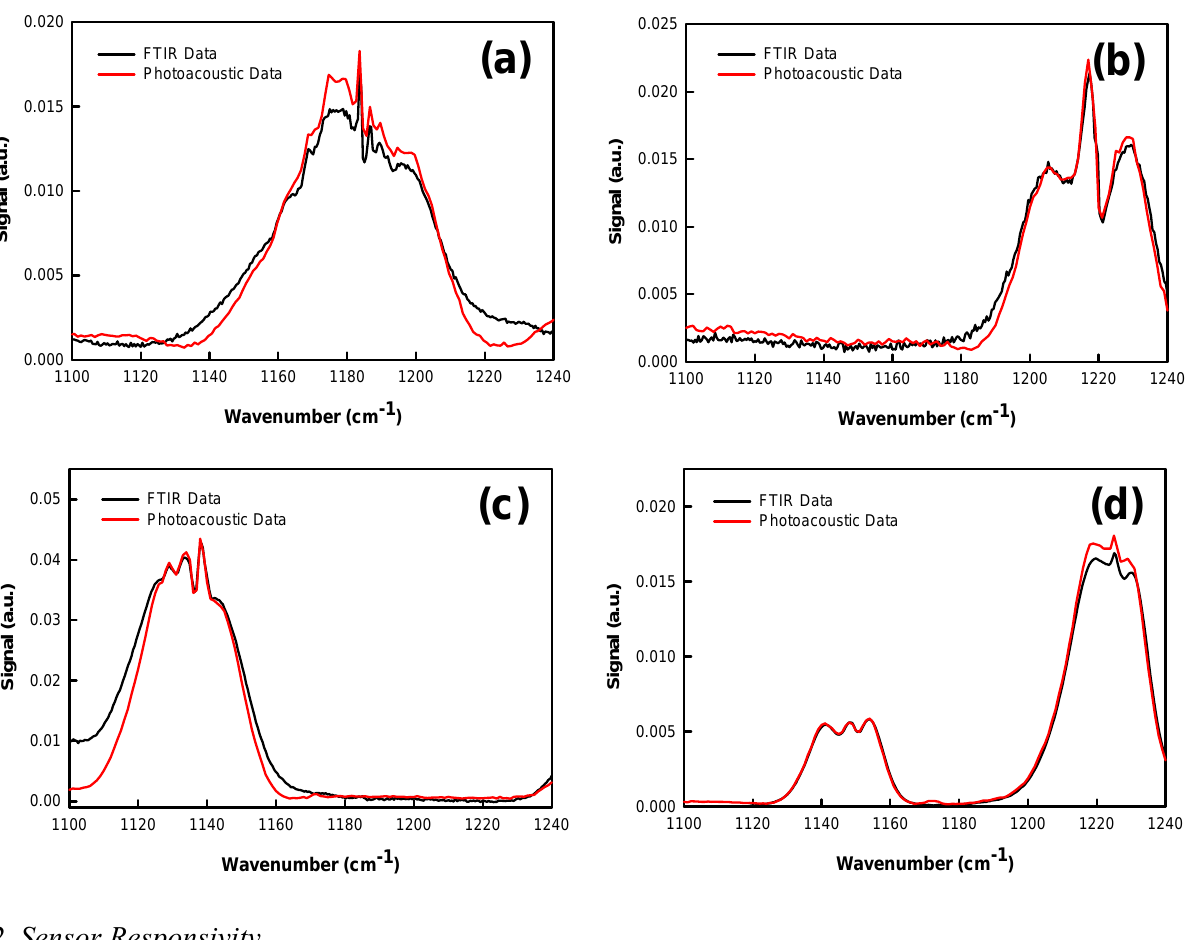
Figure 4. Measured laser photoacoustic spectrum of (a) acetic acid; (b) acetone; (c) 1,4-dioxane; and (d) vinyl acetate compared to FTIR reference